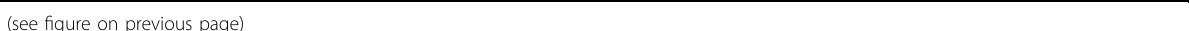
(see fi gure on previous page) Fig. 1 TMEM151A variants cause paroxysmal kinesigenic dyskinesia. a The pedigree structure and segregation analyses of Families 1 – 3 and sequencing chromatograms of the identi fi ed TMEM151A variants. The upper chromatogram represents the normal sequence, and the lower represents the variant. Square: male; circle: female; arrow: index patient; fi lled symbol: affected; open symbol: unaffected; + : wild-type allele. b Sequencing chromatograms of TMEM151A variants identi fi ed in eight isolated PKD patients. c Relative expression level of Tmem151a mRNA in various organs of 2-month-old mice. The expression level in the heart was used as a calibration (means± SEM, n = 3). d Relative expression level of Tmem151a mRNA in the developing mouse brain. The expression level in P0 was used as a calibration (means± SEM, n = 3). e Relative expression level of Tmem151a mRNA in different regions of the central nervous system. The expression level in the olfactory bulb was used as a calibration (means± SEM, n = 3). f In situ hybridization for Tmem151a in the P14 mouse spinal cord. Scale bar, 200 µm. g , h In situ hybridization for Tmem151a in the P14 mouse brain. Ctx cortex, Hip hippocampus, Ob olfactory bulb, Crb cerebellum, Tha thalamus, DG dentate gyrus, ML molecular layer, GCL granule cell layer, WM white matter. Roman numerals (I – VI) indicate layers of the cerebral cortex. Scale bar, 500 µm in g , 100 µm in h . i , j Fluorescence images of COS-7 cells ( i ) and primary cortical neurons ( j ) transfected with EGFP-tagged Tmem151a and immunostained with antibodies against GFP (green) and either the ER marker calnexin (red) or anti-Tau1 antibodies (axon marker, red). DAPI (blue) was used for nuclear staining. Scale bar, 10 µm. k Western blots of protein obtained from HEK293T cells transfected with WT and mutant pIRES2-Flag-TMEM151A plasmids. The anti-Flag antibody was used to detect the TMEM151A protein. The GFP was used to measure the transfection ef fi ciency and served as an internal control. Bar graph shows protein expression level. Data are presented as means ± SD, n = 3, **** P < 0.0001. l The number of dyskinesia attacks in WT, heterozygous Tmem151a + / − , and homozygous Tmem151a − / − mice in 48 h. m Duration of spontaneous dyskinesia attacks in Tmem151a − / − mice. One dot represents one observed attack. n Representative images of dyskinesia attacks in a Tmem151a − / −